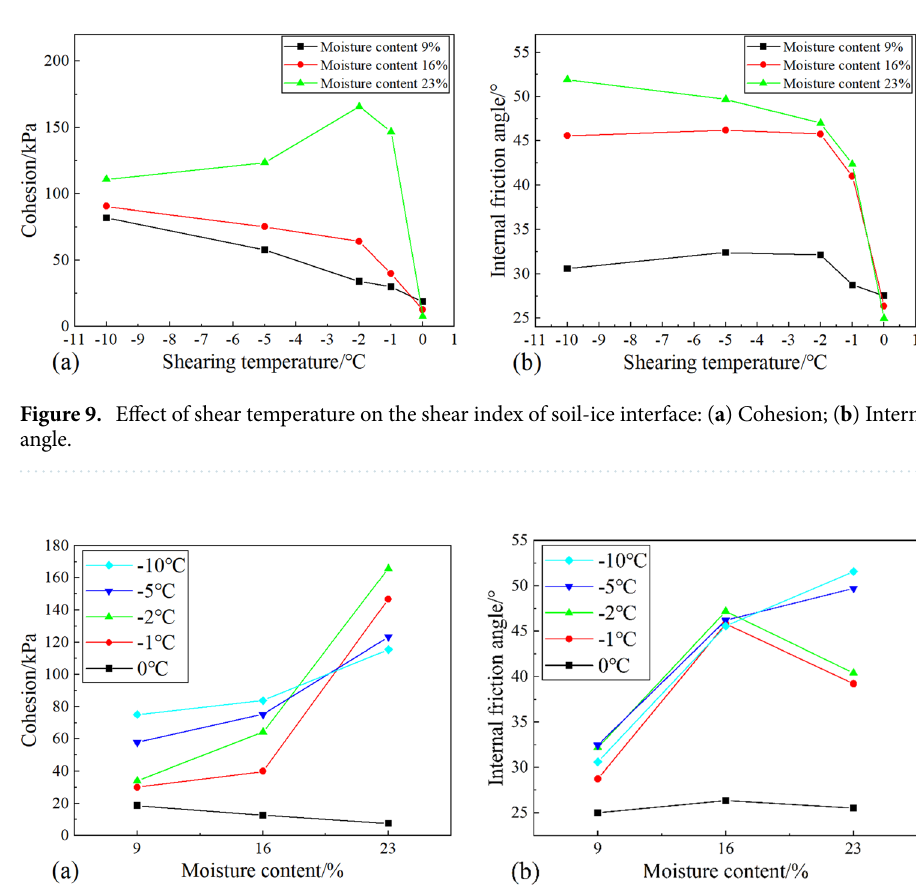
Figure 10. Effect of moisture content on the shear index of soil-ice interface: ( a ) cohesion; ( b ) internal friction